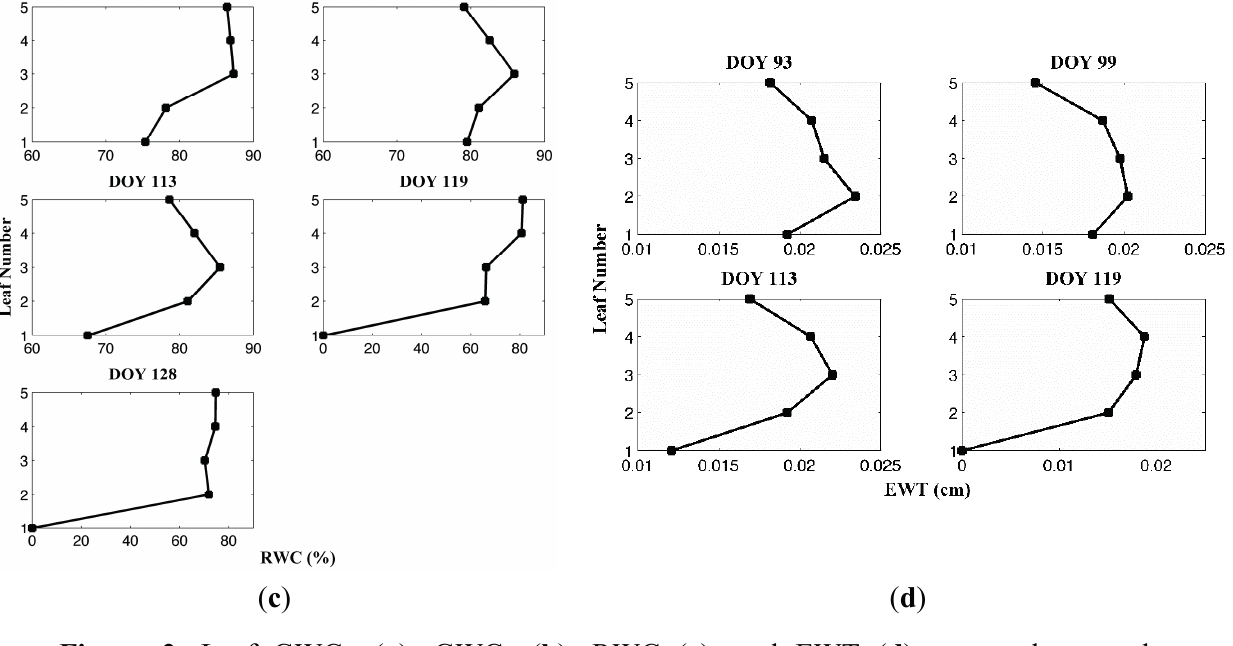
Figure 2. Leaf GWC D ( a ), GWC F ( b ), RWC ( c ), and EWT ( d ) averaged on each measurement date versus leaf number from the top (No.5 refers to the top leaf) to the bottom (No.1 refers to the bottom leaf) of the winter wheat